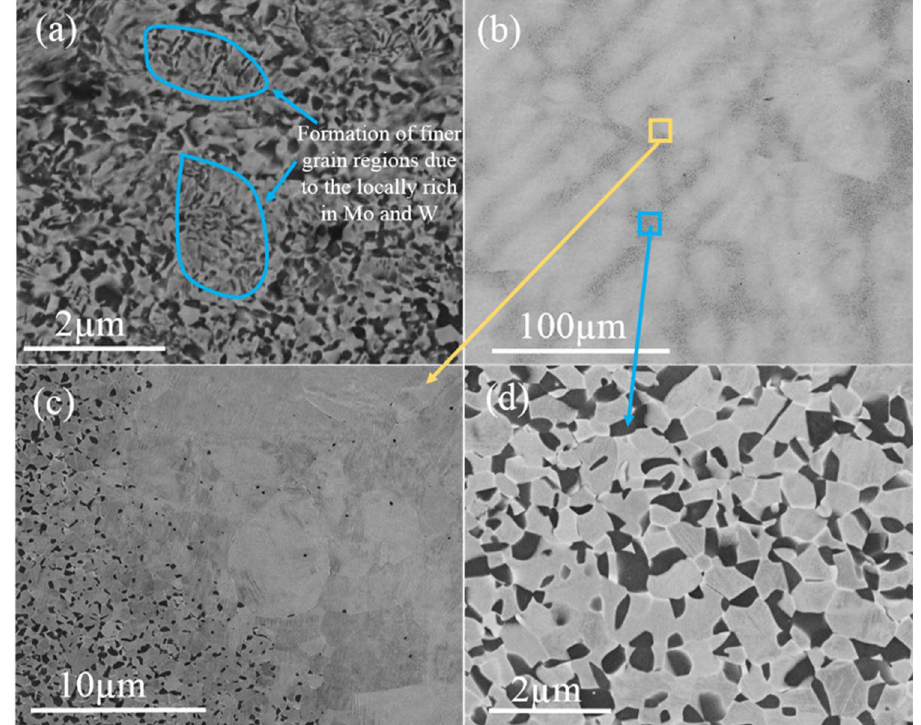
Figure 1. Backscattered SEM micrographs of the Ti-9Mo-6W alloy after annealing: ( a ) 820–2 M and ( b ) 820–5 M. ( c ) and ( d ) are high magnification images of 820–5 M: ( c ) from the interface between black and white regions and ( f ) from the back regions observed in ( b ).